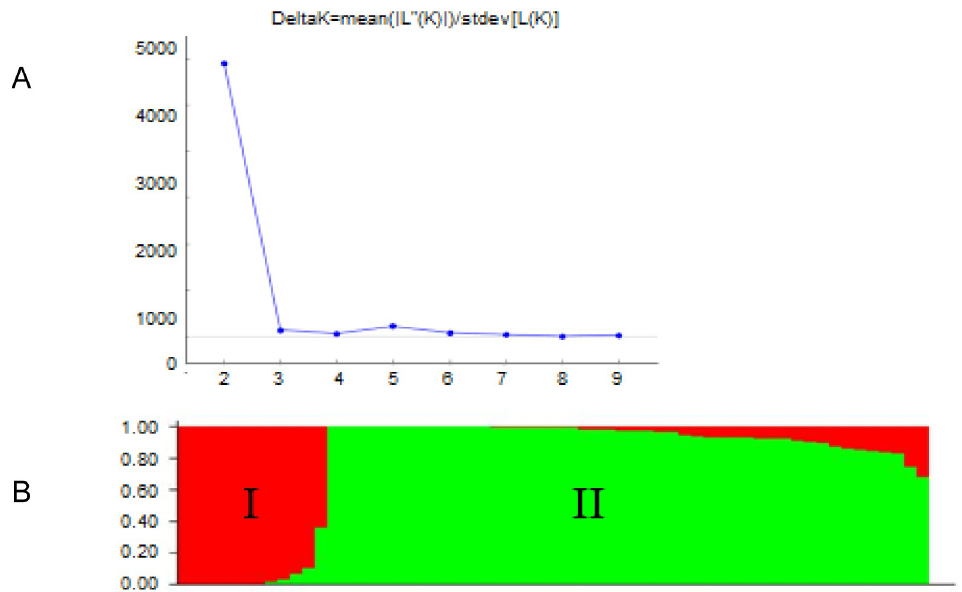
Fig 4. Population structure of 60common bean genotypes based on 16565 SNP markers. A. Highest delta K values showing K = 2. B. Genotype membership to the two clusters.